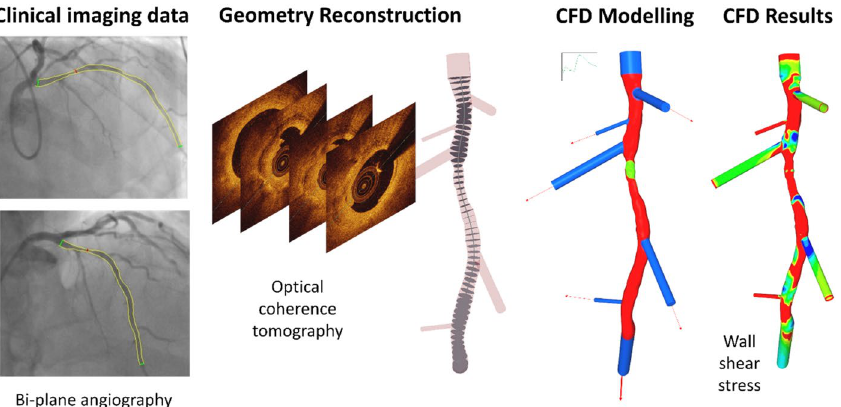
Figure 4. Probing the haemodynamic conditions permissive for plaque erosion. OCT and bi-plane angiography of coronary arteries were collected and used to reconstruct lumen geometries (n = 17). Red sections are high accuracy reconstructions from hybrid OCT/bi-plane angiography, blue sections use bi-plane angiography and OCT to determine the diameter and branch of angle for the flow extensions, with adherent thrombus in green. At ‘rest’ and ‘exercise’ pulsatile flow conditions were simulated for 4 cardiac cycles. Haemodynamic flow results were post-processed to quantify additional wall shear-based haemodynamic metrics of interest. Ensight 10.2.3, was used to post-process and visualise the